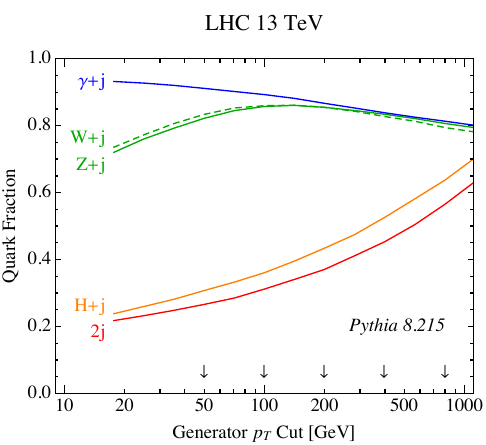
Figure 16. Quark fraction of jets at parton level, as de(cid:12)ned by the Born-level parton (cid:13)avor. The arrows indicate the p min values used for the study in section T